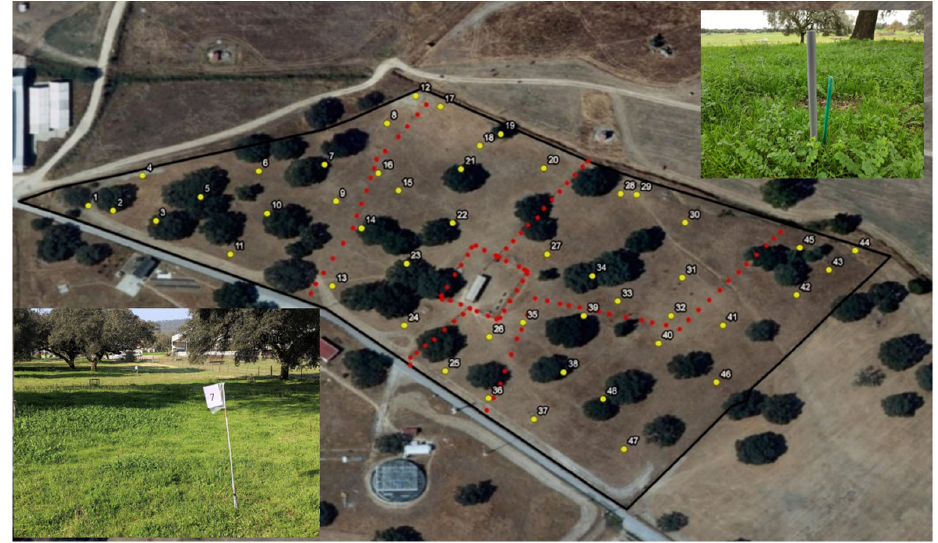
Figure 4. Representative sampling points of different pasture plant communities and sample point marking example.